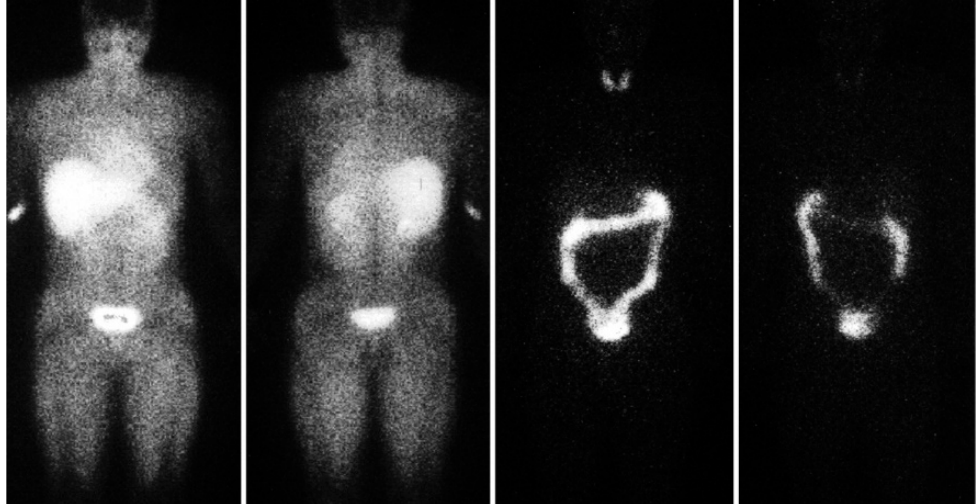
Figure 1. Typical immediate (0–30 min) anterior ( left ) and posterior ( left centre ) views and 22 h anterior ( right centre ) and posterior ( right ) planar images after 123 I-IAZA intravenous administration to volunteers. Images were adapted from Stypinski et al. 2001. [9].